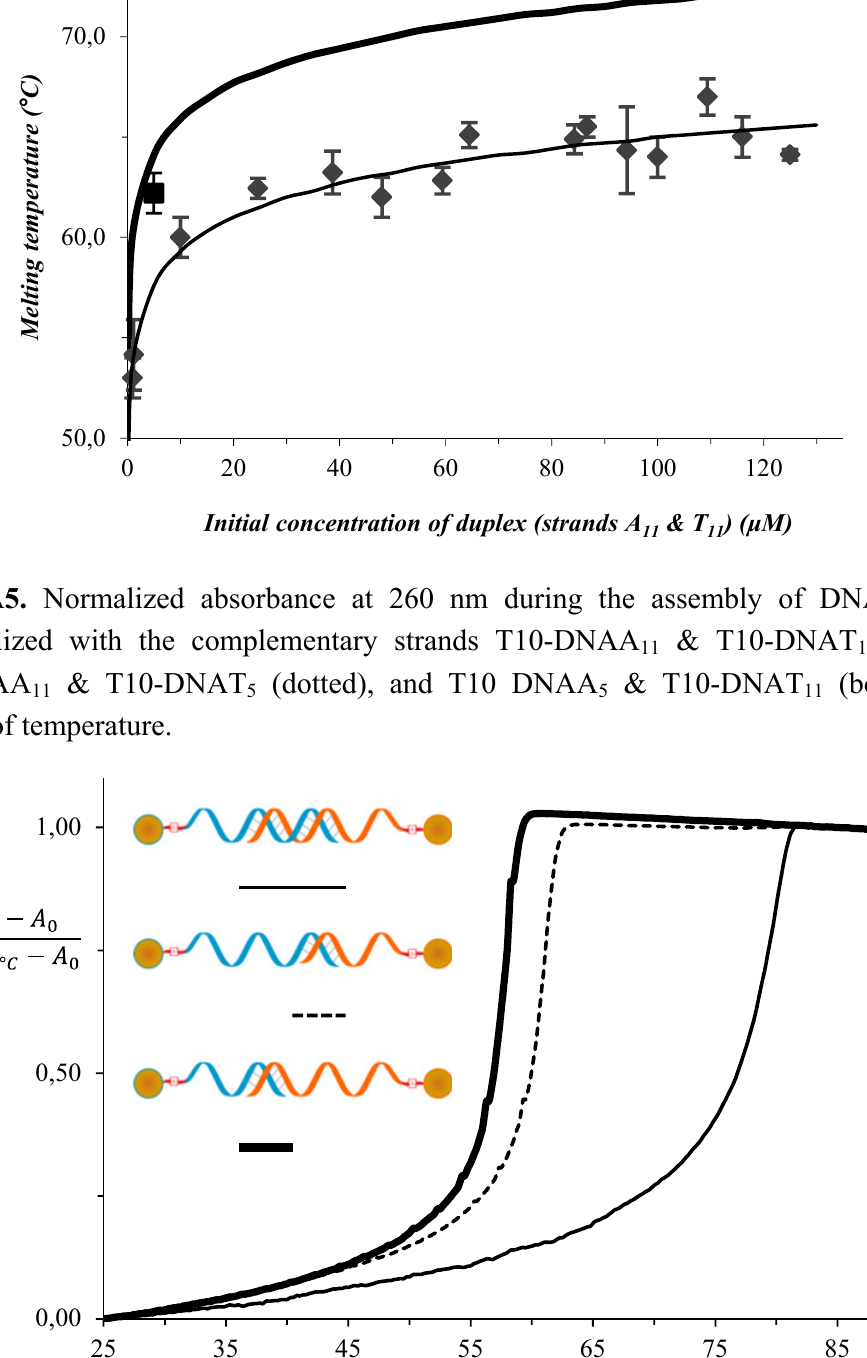
& T in function of duplex 11 11